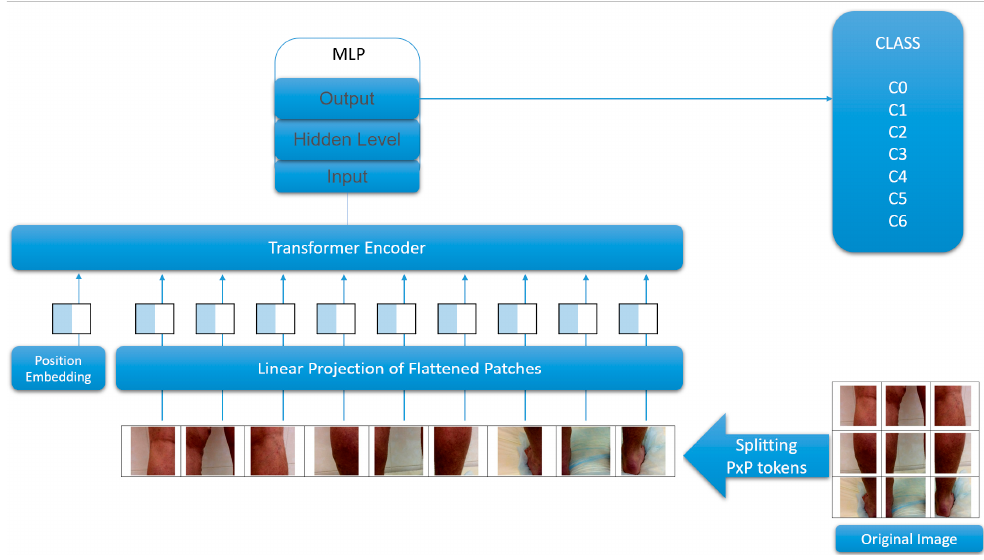
Figure 9. The Visual Transformers architecture.